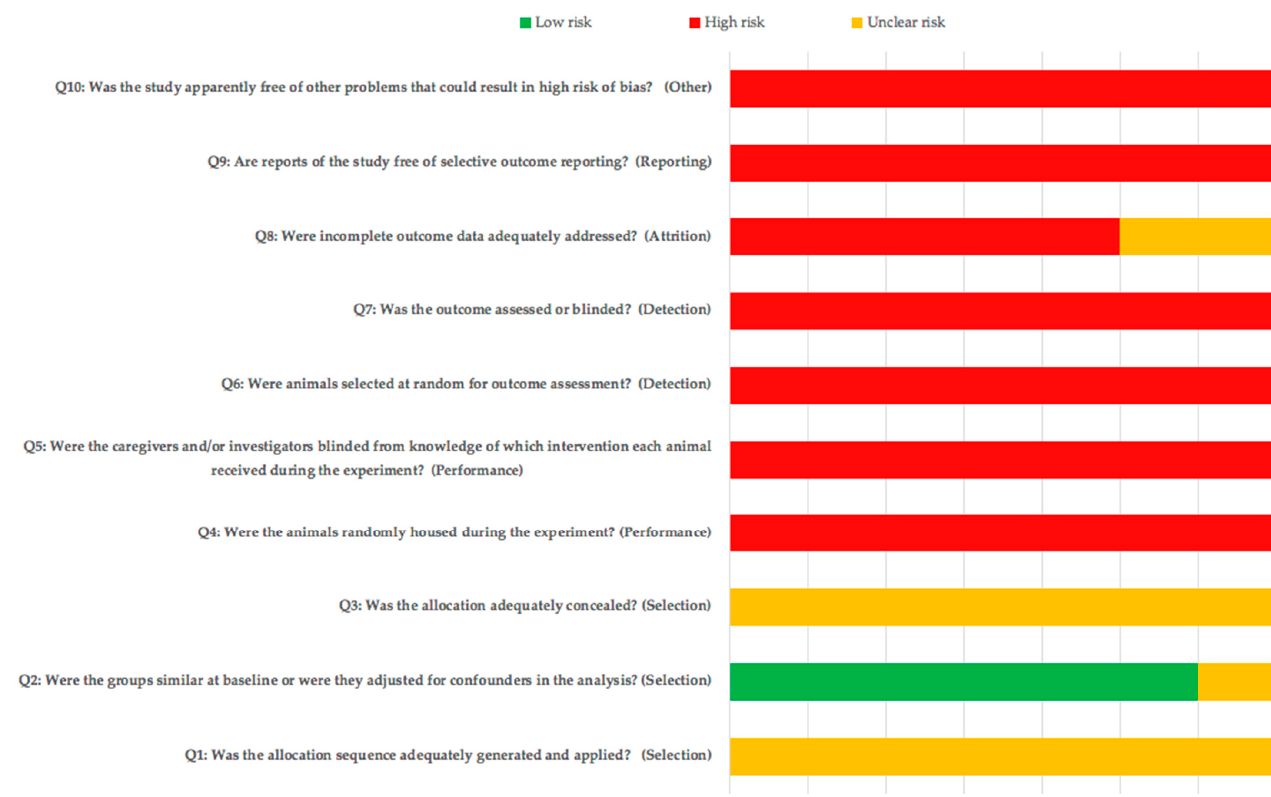
Figure 3. SYRCLE’s (Systematic Review Centre for Laboratory animal Experimentation) risk of bias tool. 15